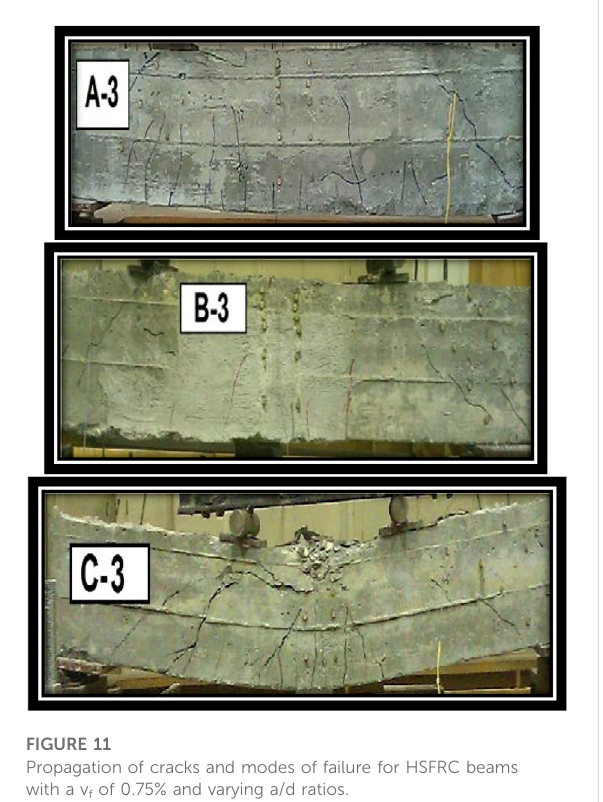
with a v f of 0.75% and varying a/d ratios.